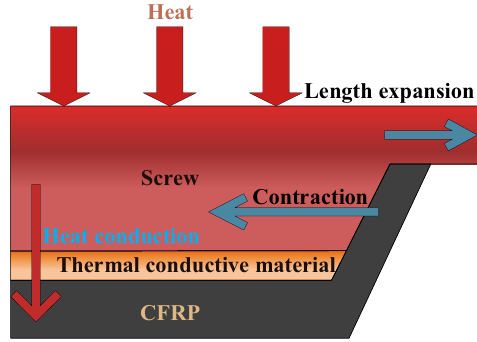
Figure 3: Schematic diagram of thermal contraction mechanism in bio - inspired ball screw.